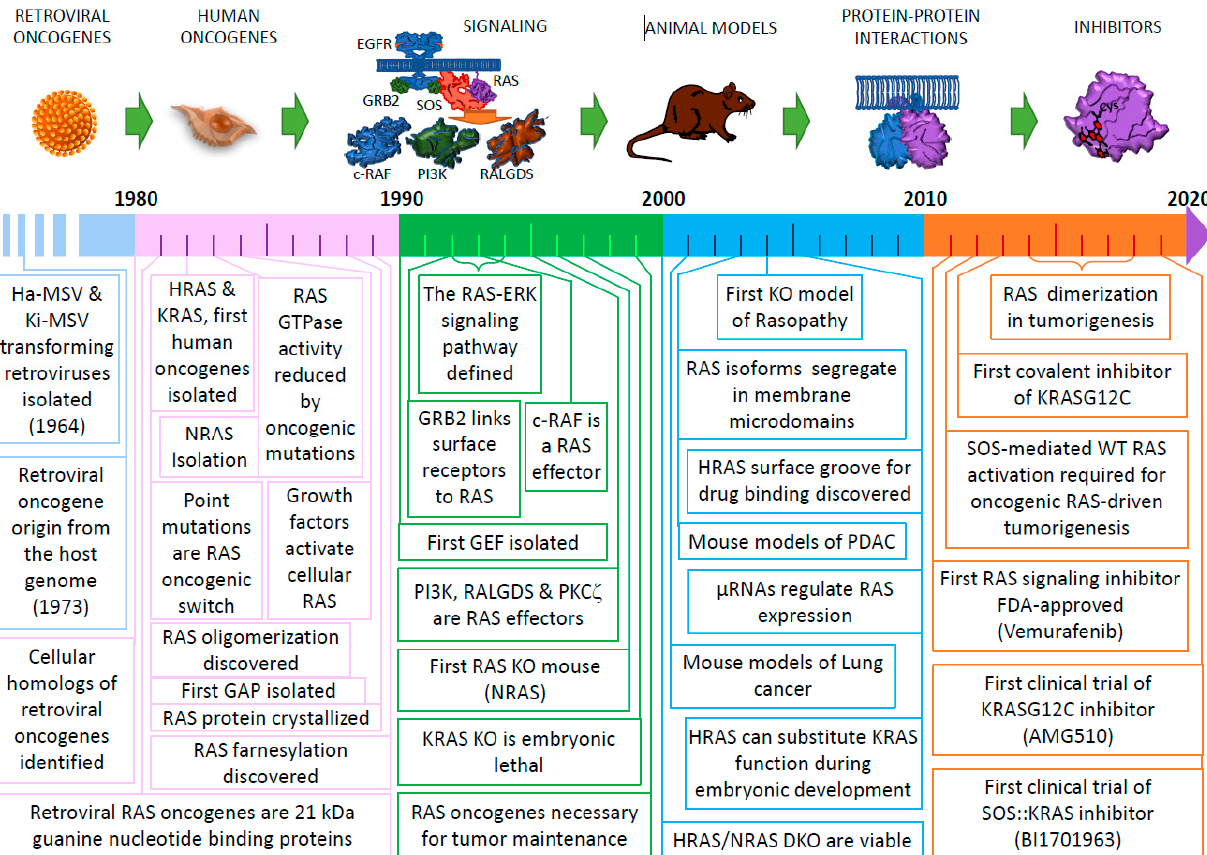
Figure 1. Milestones in RAS research. Summarized timeline of some key discoveries in RAS research over the last 40 years. We apologize for many key discoveries that could not be included here due to lack of space. The individual boxes point to the year of publication of some selected research advances that significantly contributed to the path leading to our current understanding of RAS structure, function and biology.